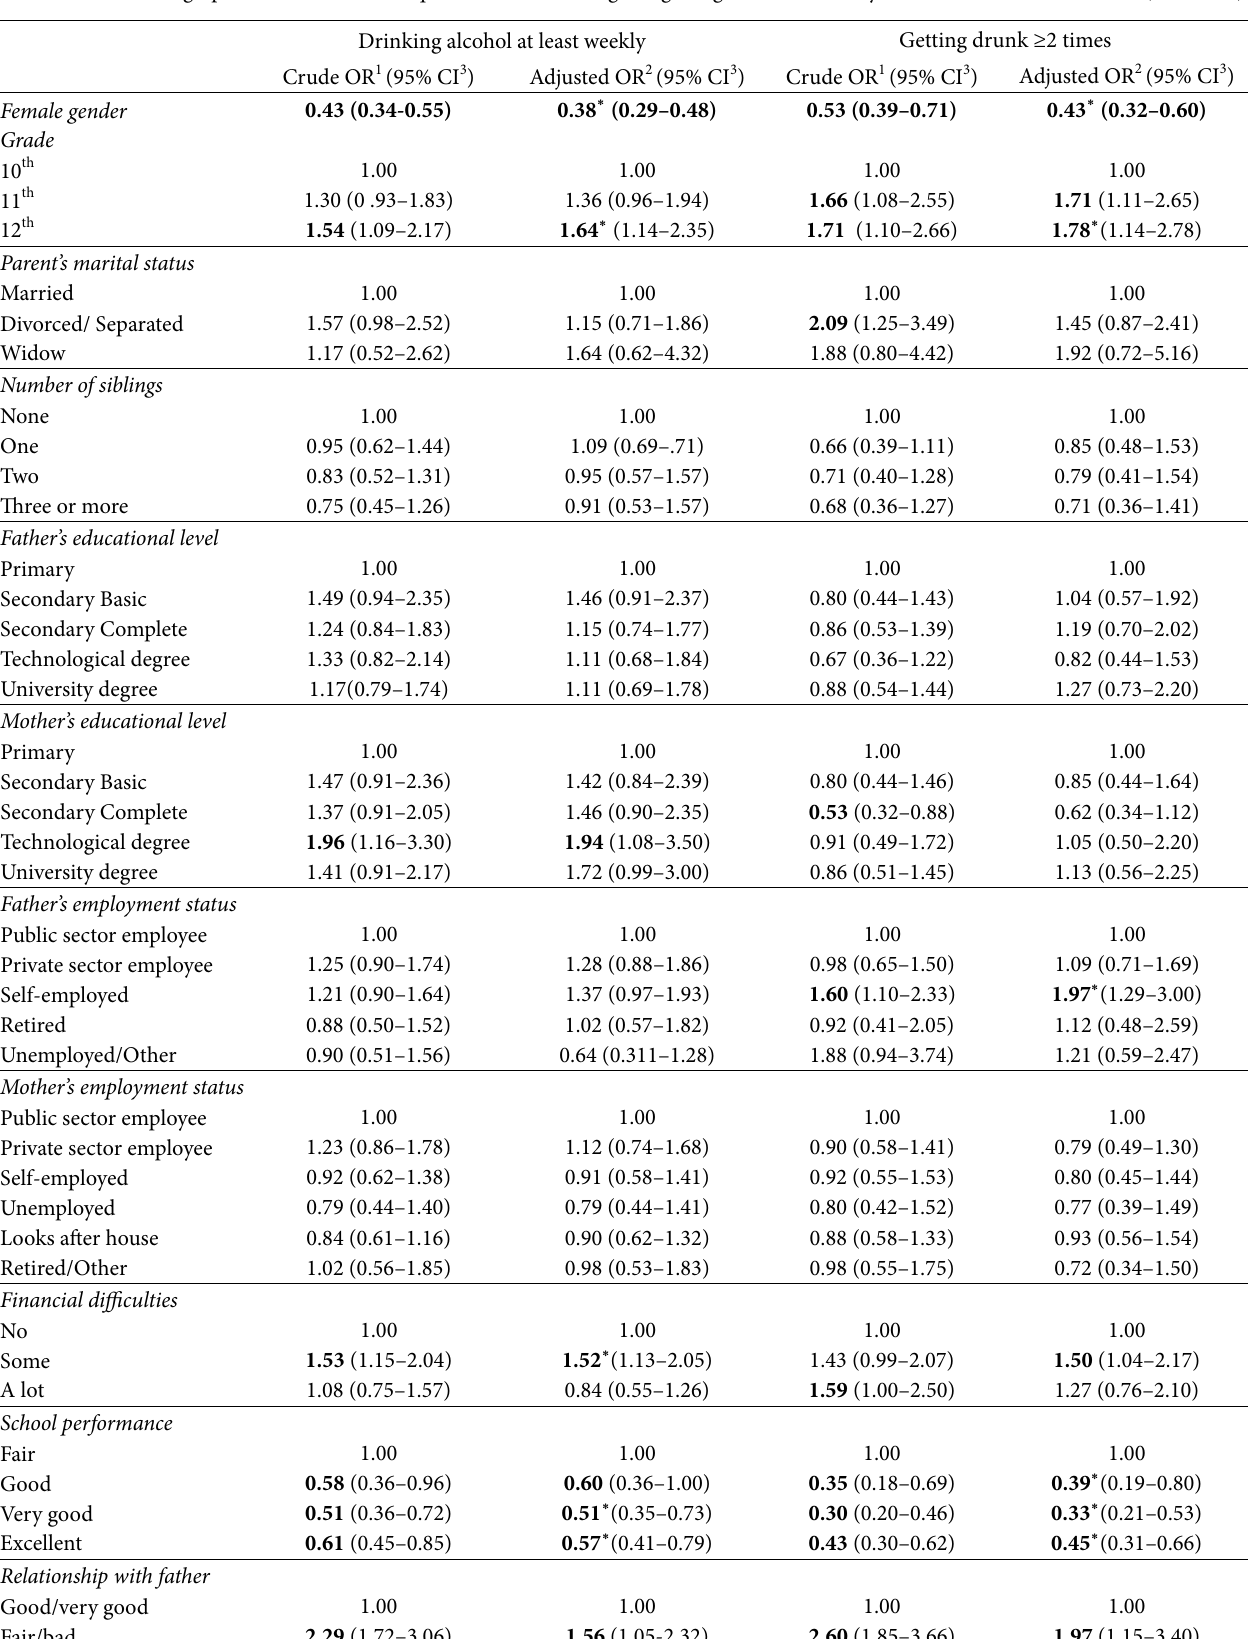
Table 2: Sociodemographic associations of frequent alcohol drinking and getting drunk in 16–18 year-old adolescents in Greece ( 𝑁 = 2431